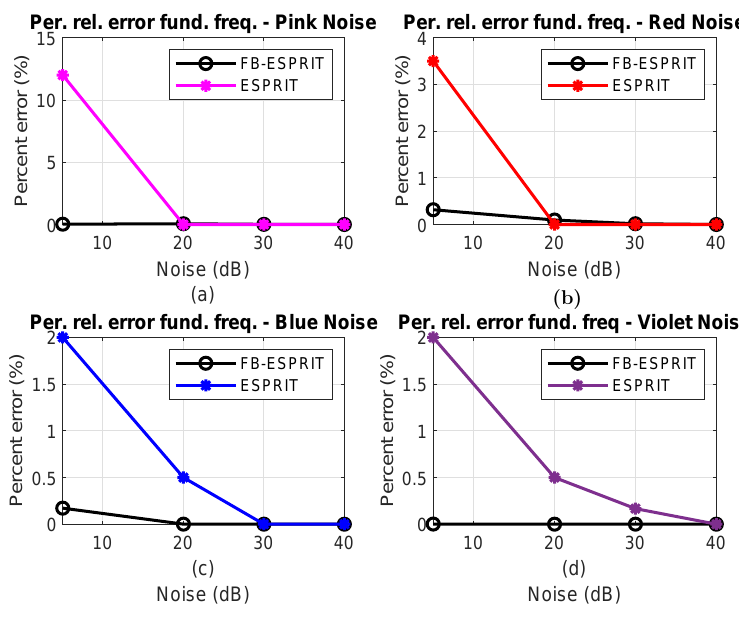
Figure 9. Percentage of relative (Per. rel.) error (%) of 60 Hz fundamental frequency (fund. freq.) estimation: ( a ) signal contaminated with pink noise, ( b ) signal contaminated with red noise, ( c ) signal contaminated with blue noise, and ( d ) signal contaminated with violet noise.